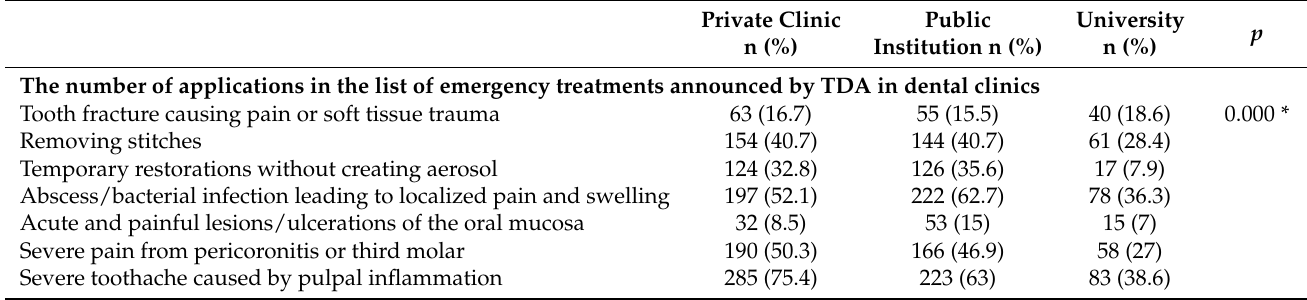
Table 7. The treatments applied by the participants in their clinics according to the treatment list declared by the TDA.